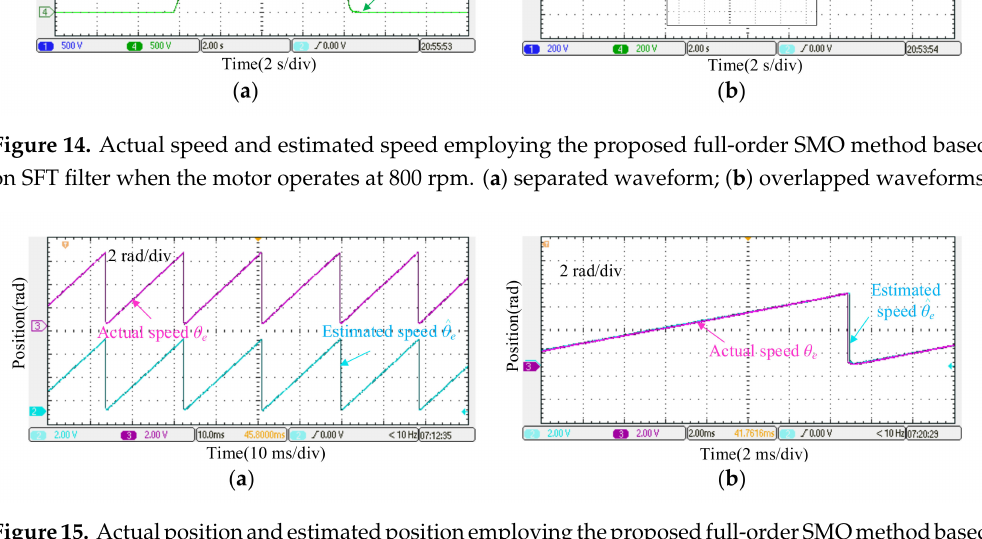
Figure15. Actualpositionandestimatedpositionemployingtheproposedfull-orderSMOmethodbased on SFT filter when the motor operates at 800 rpm ( a ) separated waveform; ( b ) overlapped